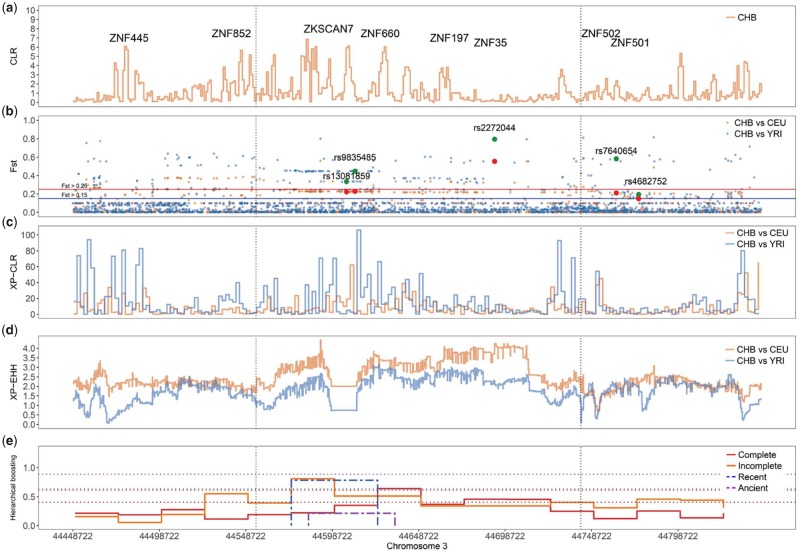
—KRAB-ZNF gene cluster exhibiting hard sweep on the chromosome 3 from CHB population (3: 44.55–44.74). Three methods for detecting positive selection and FST for measuring genetic differentiation produced very high scores for this region (a–d) when compared with other regions genome wide. Note that the scale on the y axis differs between plots. All values correspond to the raw scores obtained for each method. FST (b) and XP-EHH (d) results indicate very high genetic differentiation and a haplotype with EHH that spans about 188 kb (vertical dotted lines). This KRAB-ZNF cluster contains eight ZNF genes. The regions flanking up and downstream of this 188-kb haplotype also exhibit EHH, which suggests that they correspond to the same selective sweep (about 272 kb). Four highly differentiated nonsynonymous SNPs (green: CHB vs. YRI; red: CEU vs. YRI) in regions coding for protein domains of ZKSCAN7, ZNF35, ZNF501, and ZNF502 may be of functional relevance. Hierarchical boosting results (e) suggest this correspond to an incomplete recent selective sweep. Solid and dotted horizontal lines indicate thresholds for FST (blue: FST > 0.15, red: FST >0.25) and boosting significance thresholds as defined by Pybus et al (2015) (red: complete, orange: incomplete, blue: recent, and purple: ancient), respectively.